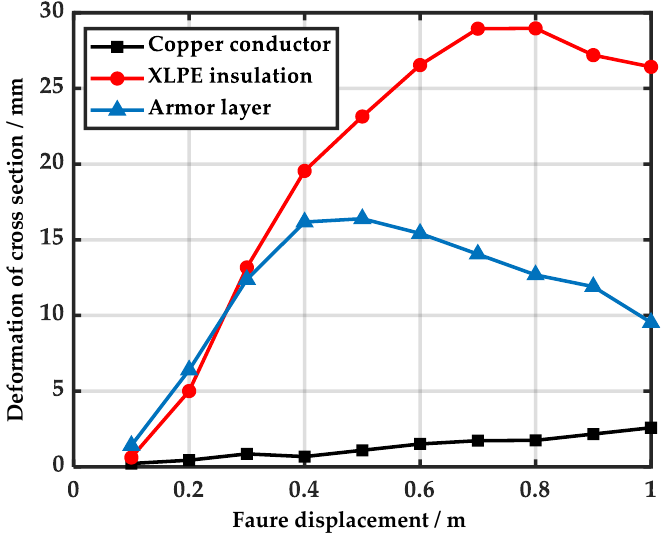
Figure 5. Deformation of submarine cable cross-section at the fault surface [22]. The black curve indicates the copper conductor, the blue curve indicates the galvanized armor layer, and the red curve indicates the XLPE insulation. When a slip fault occurs, the structural deformation of each layer of the submarine cable is different, and the damage caused to it is also different.